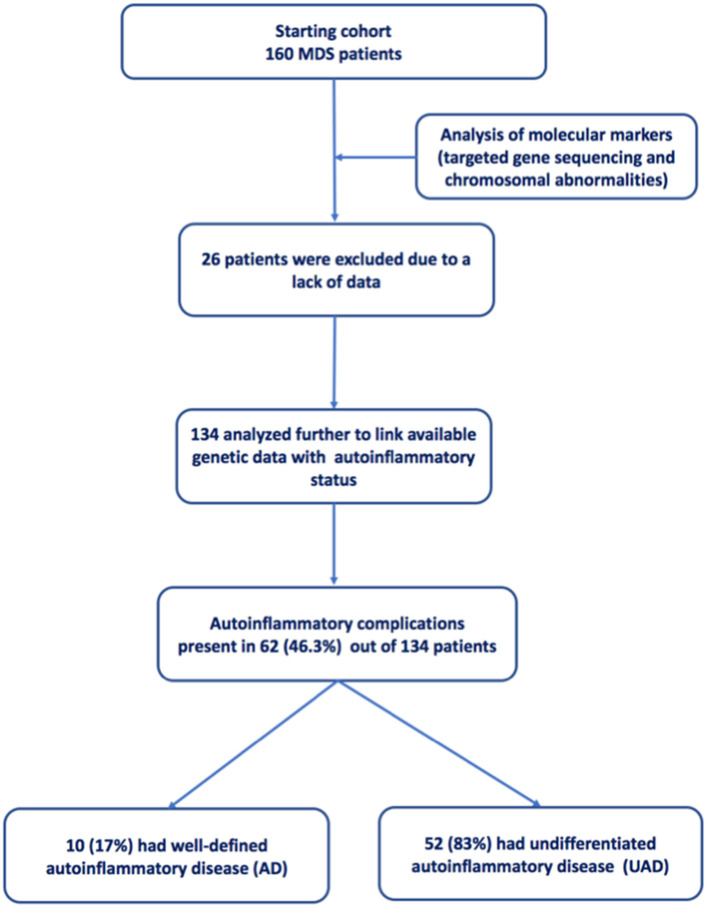
Flow chart describing the screening and selection of MDS patients.